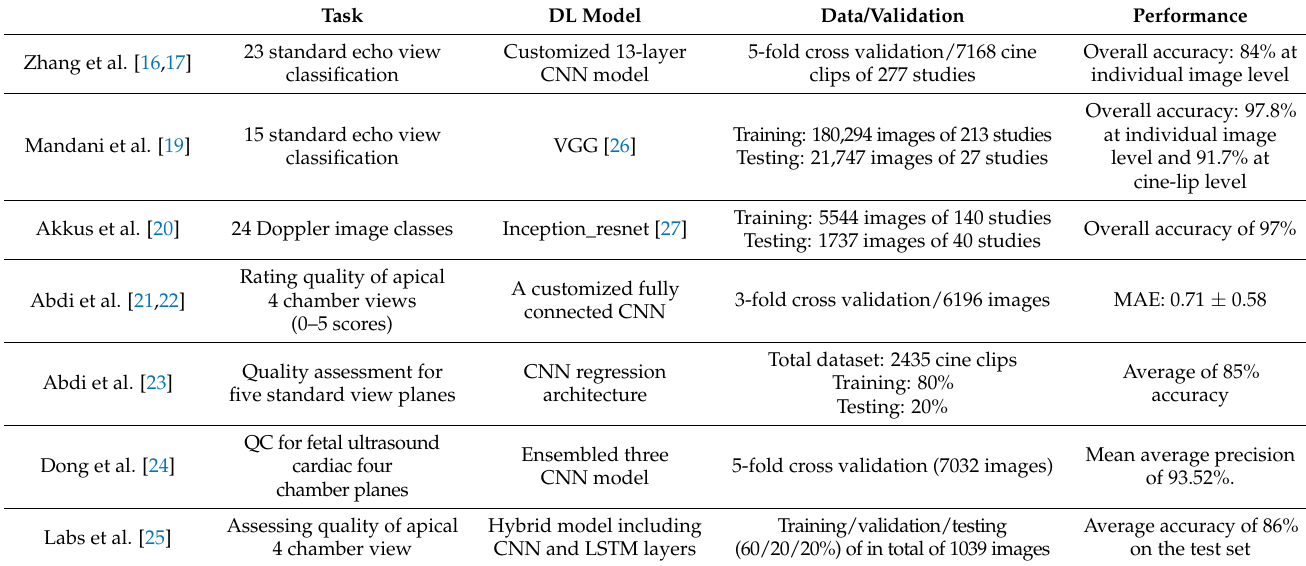
Table 2. Deep-learning-based AI studies for view identification and quality assessment. MAE: mean absolute error. Task DL Model Data/Validation